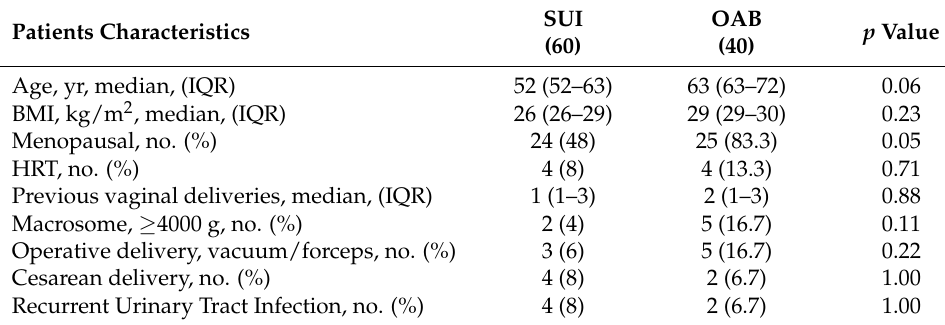
Table 2. Baseline patients characteristics.